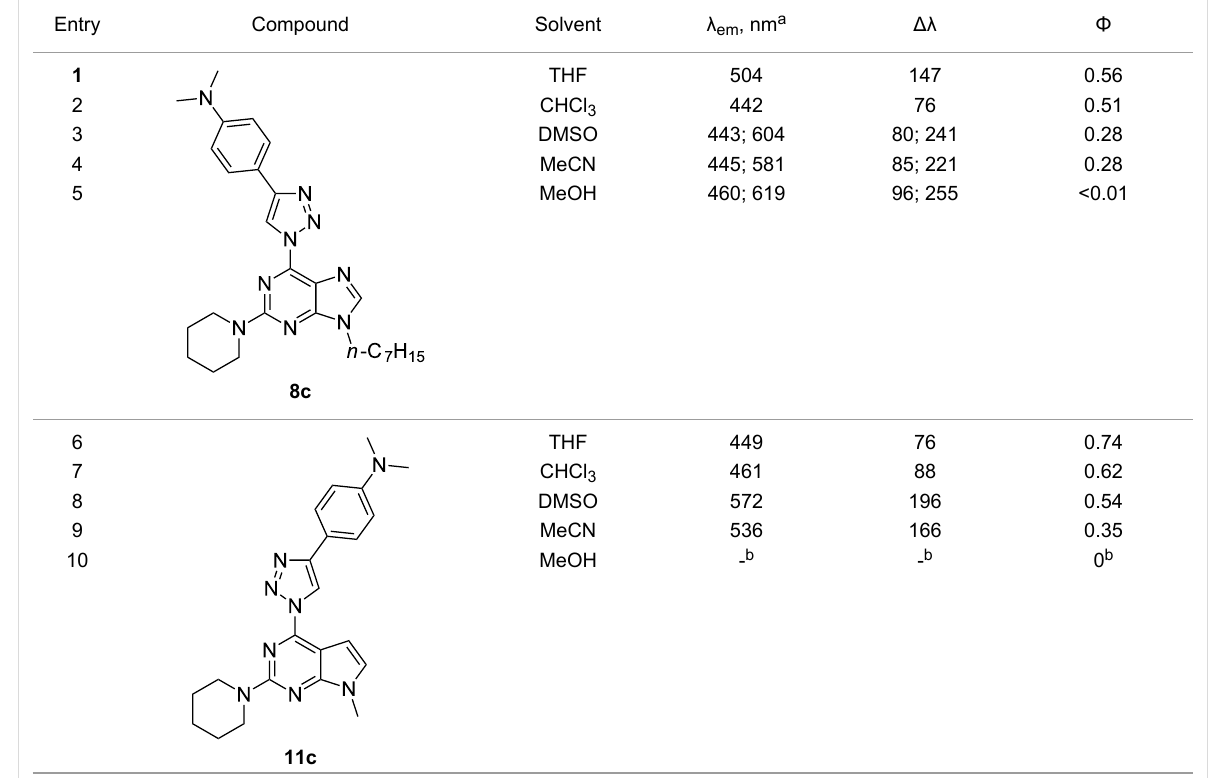
Table 4: Emission maxima and quantum yields of compound 8c and 11c in solvents of different polarity.